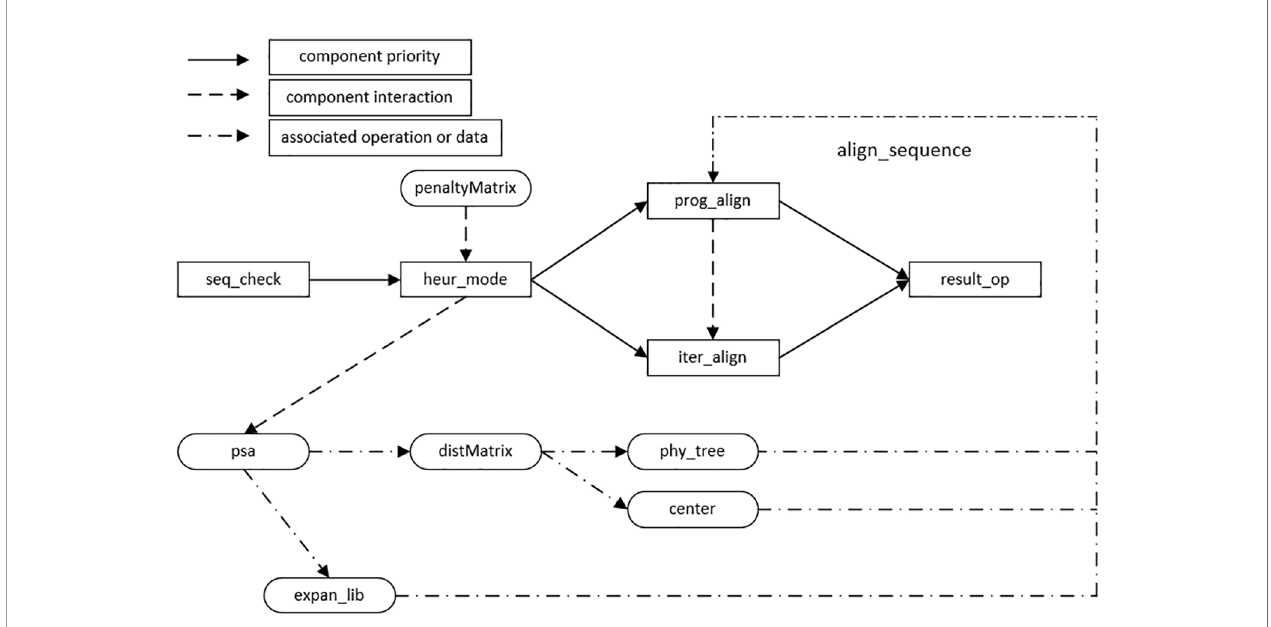
FIGURE 4 | Algorithm components interaction model.